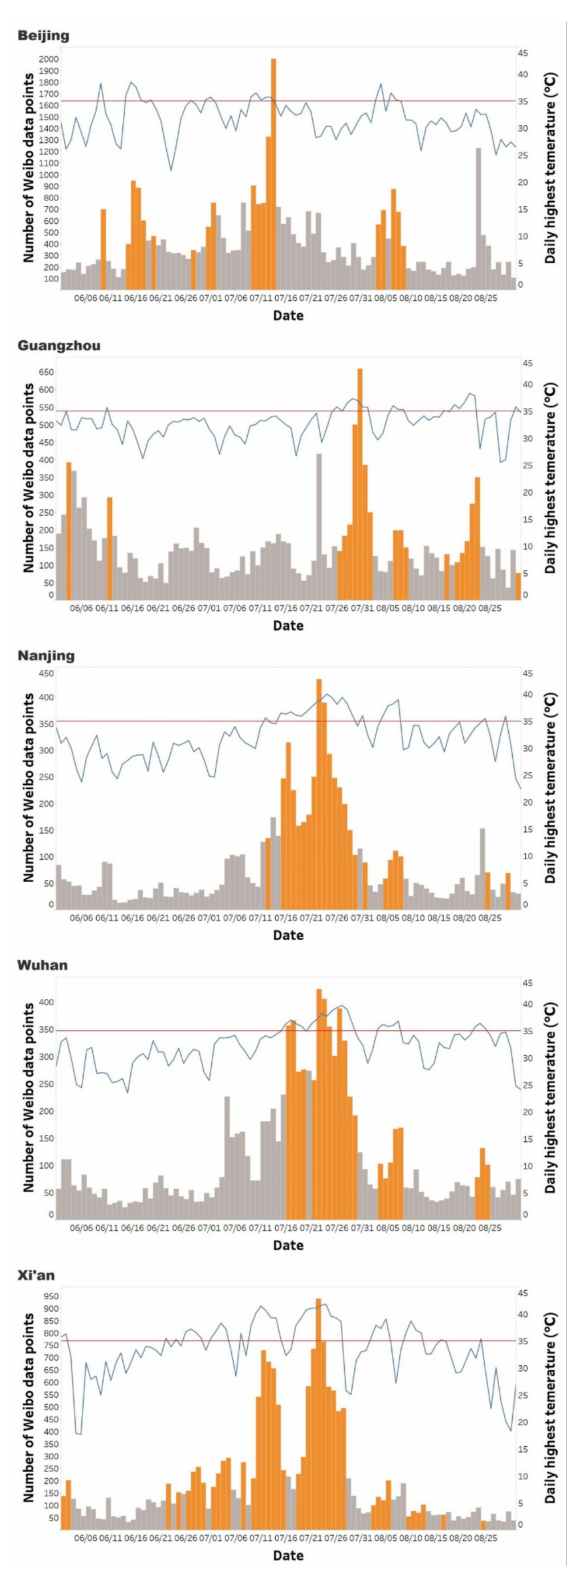
Figure 3. Temporal trend correlation of HWEs and the residential sensitivity to HWEs (orange: the number of HWE-related Weibo data points on heatwave days; gray: The number of HWE-related Weibo data points on other days). The red line shows the temperature of 35 ◦